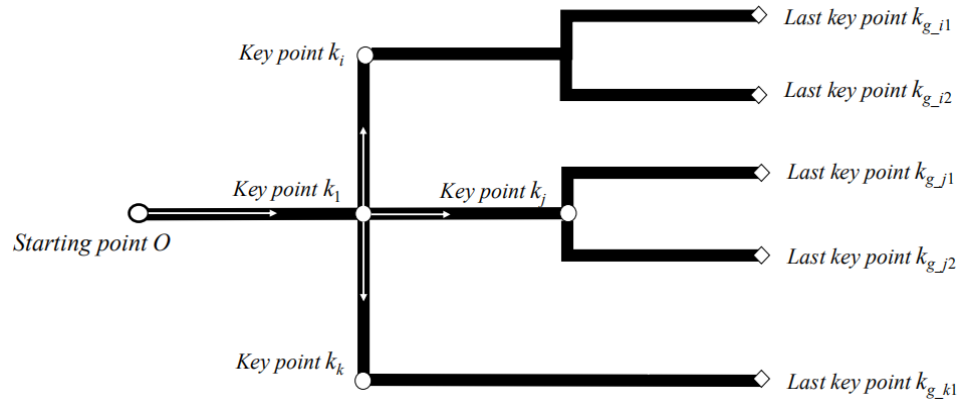
Figure 2. Schematic diagram of key point mining.